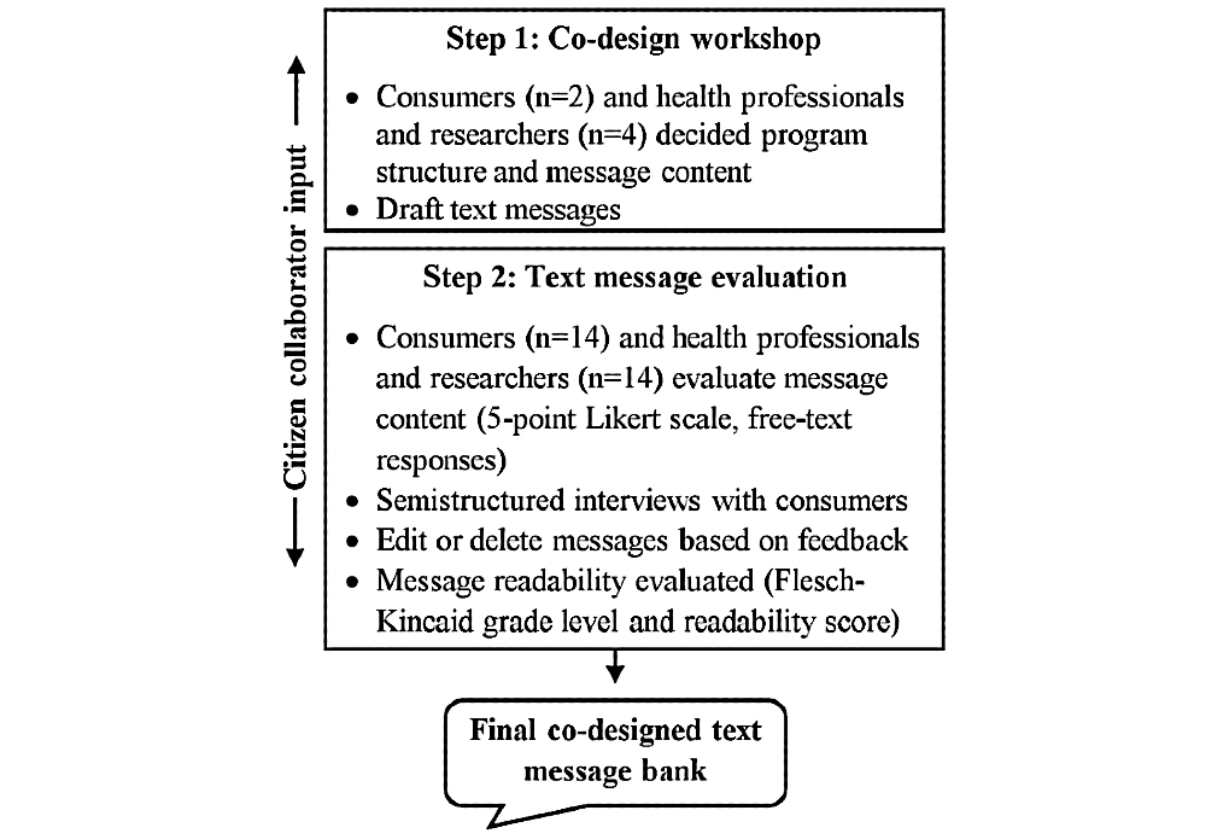
Figure 1. Study design, including a citizen collaborator